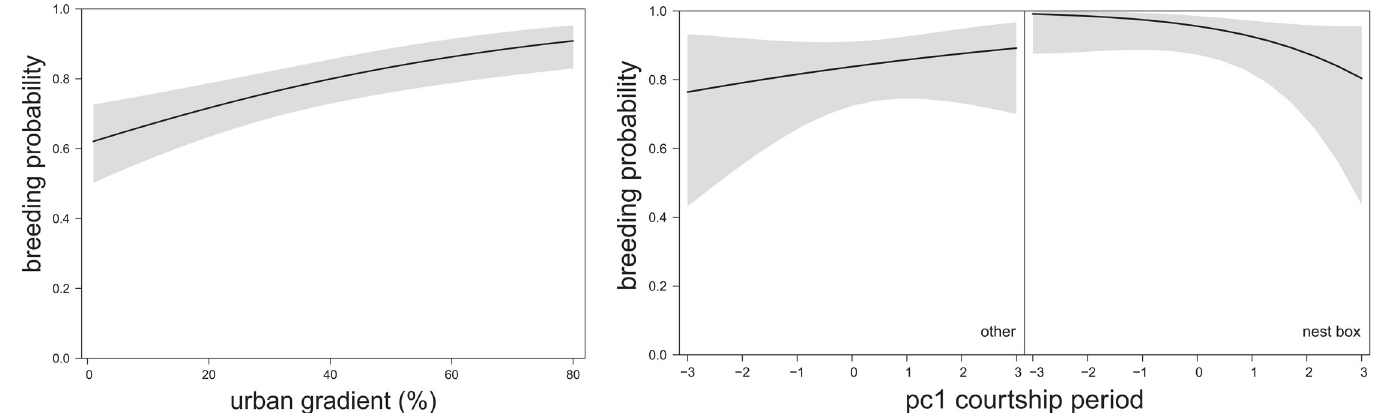
Fig 2. The relationship between breeding probability and (a) the urban gradient from the full data set (estimate 0.58 ± 0.15 SE, χ 2 (n = 676) = 15.25, P < 0.001); and, (b) nest type (building with nest box versus other) in interaction with rainfall from the urban subset (including only nests with > 40% urban cover; estimated interaction effect on the logit scale -0.71 ± 0.35 SE, χ 2 (n = 255) = 4.00, P = 0.046) [negative values: high precipitation (total sum of rain, number of rain days and rain intensity); positive values: low precipitation] during the courtship period based on predicted values of GLMM, 95% CIs in shaded grey. Model details in Table 1.